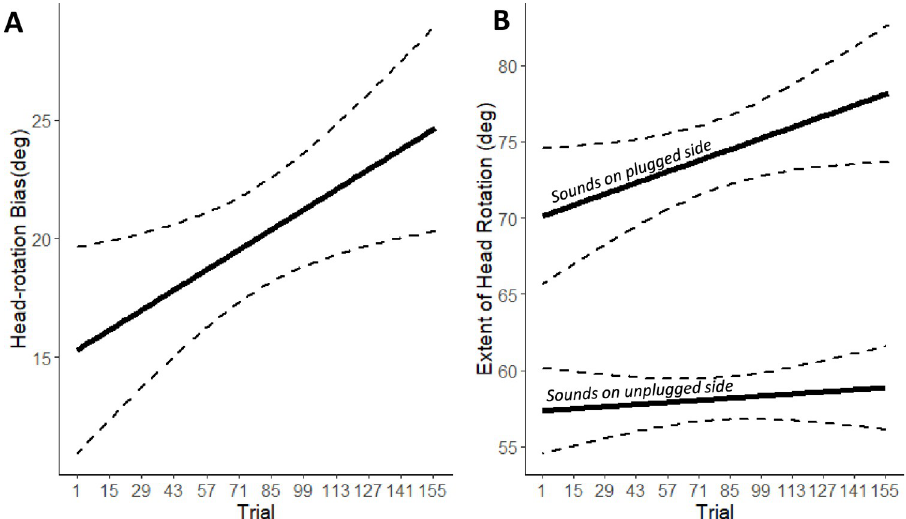
Fig 6. Changes in head behavior during the spatial training. Head-rotation bias as a function of trial (A) and extent of head-rotation as a function of trial and separately for sound delivered to the left or to the right of participant’s midline (B). Dashed lines indicate the 95% confidence intervals of the overall linear